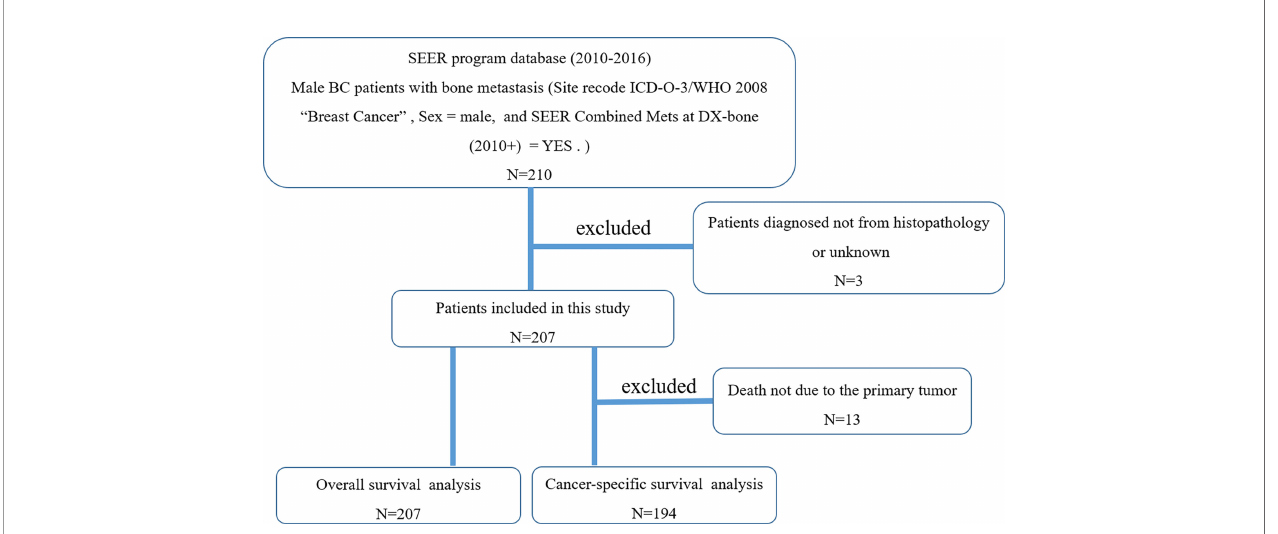
FIGURE 1 | The fl owchart for selection of study population. (SEER, Surveillance, Epidemiology, and End Results; ICD-O-3, International Classi fi cation of Diseases for Oncology, 3rd edition; BC, breast